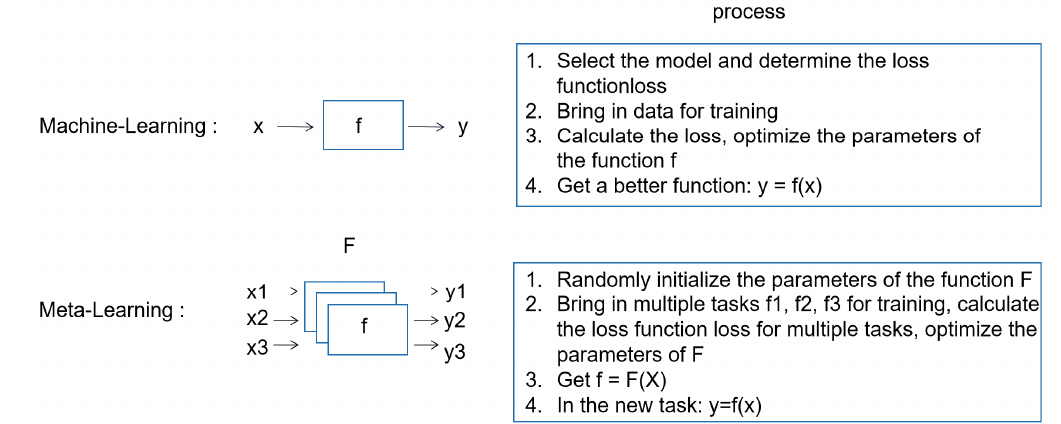
Figure 2. The difference between meta-learning and machine learning.